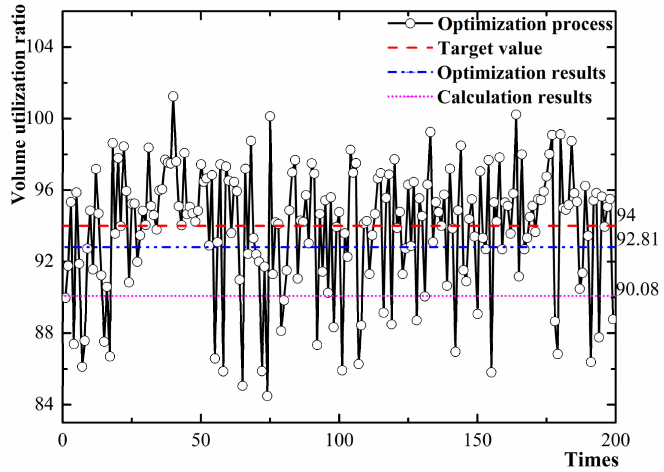
Figure 8. Volume utilization ratio optimization process, optimization results, and calculation results.